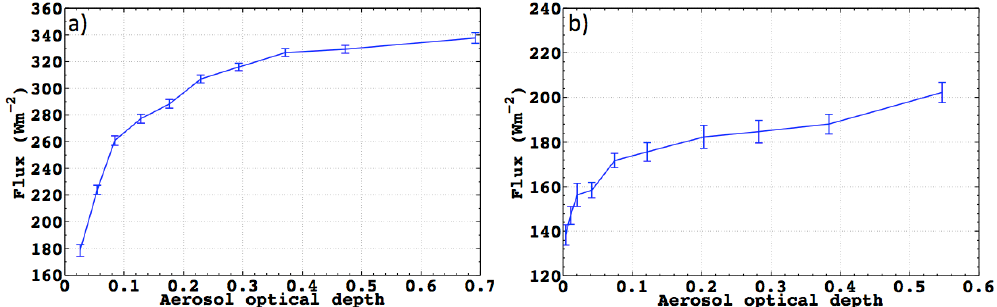
Figure 5. Mean oblique-view CERES fluxes and the relative RMSE (Eq. 6, in %) between oblique-view and near-nadir-view fluxes as a function of MODIS aerosol optical depth (a) over clear land and (b) clear Amazon (0–30 ◦ S, 40–80 ◦ W). The RMSEs are shown as error